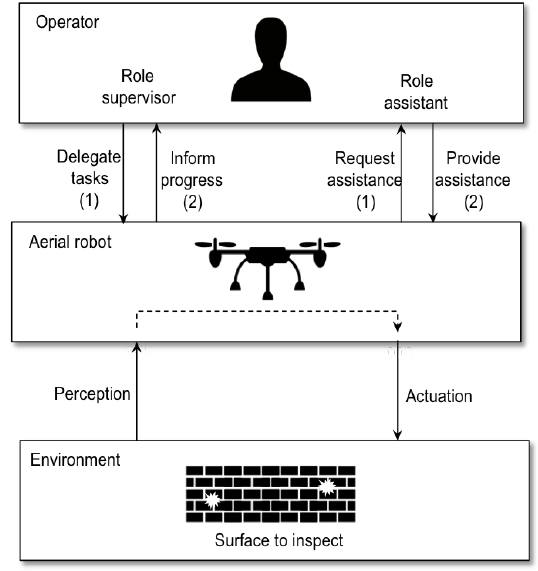
Figure 1. Human-robot interaction in surface inspection.